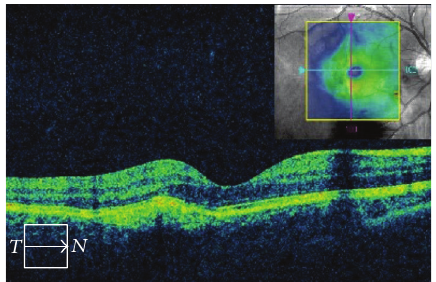
Figure 4: Optical coherence tomography showing intact